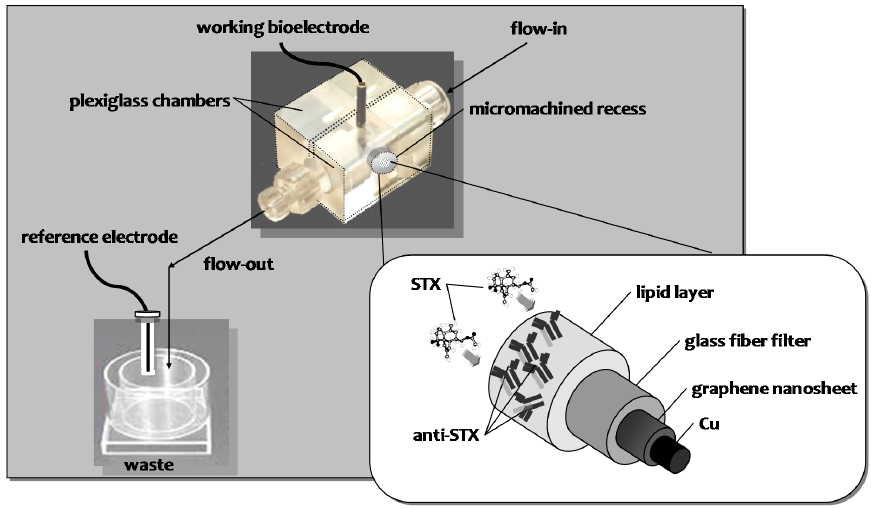
Figure 4. A schematic presentation of the lipid film modified graphene electrochemical biosensor and the bioelectrode edge surface.